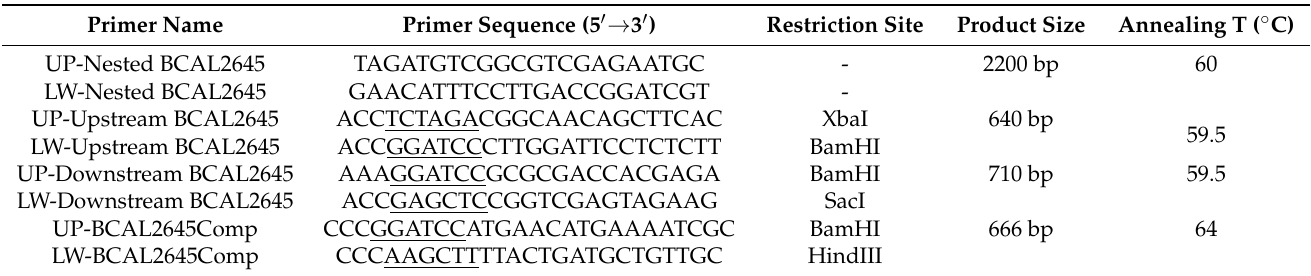
Table 2. List of primers used in this work, showing primers names, sequence, amplicon sizes and annealing temperatures. Restriction sites are represented as underlined